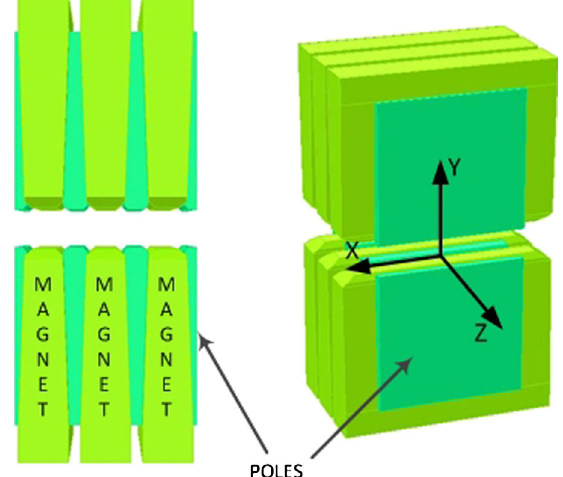
FIG. 4. The simulation model (with magnets) for the UNA33 #6 geometry.